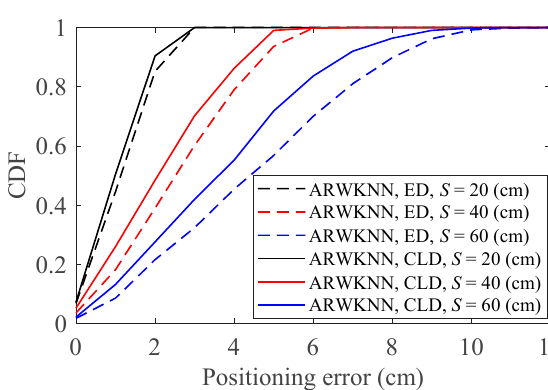
Figure 20. In 2-D, the cumulative distributions of positioning errors for the ED and CLD metrics with various S values. K max = 4.